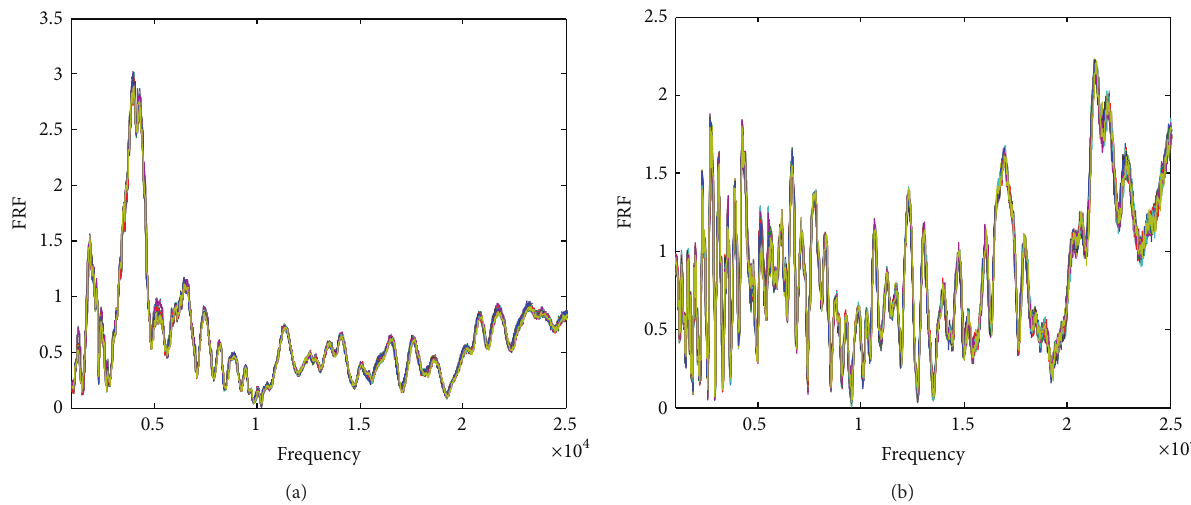
Figure 8: Identified FRFs. (a) Ch3, (b) Ch4. 20 measurements (from 260 k to 506 k cycles) are overlapped in the figure.